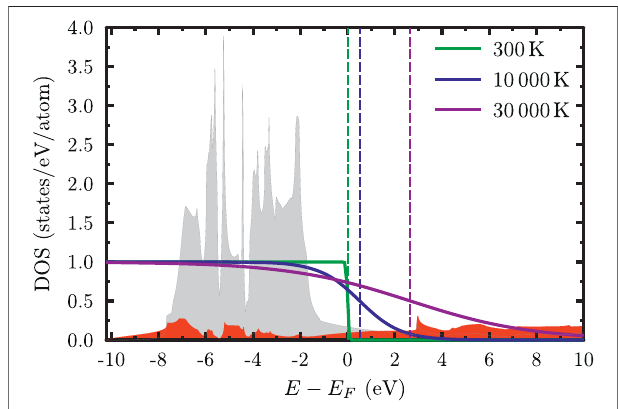
FIGURE 1 | Partial density of states in gold for the 6 sp electrons (red area) and the 5 d -band (gray area), together with the equilibrium Fermi distributions at room temperature (green line), at 10000 K (blue line) and at 30000 K (purple line). The Fermi energy E F is located at energy zero. Dashed lines are the chemical potential demonstrating a shift at elevated electron